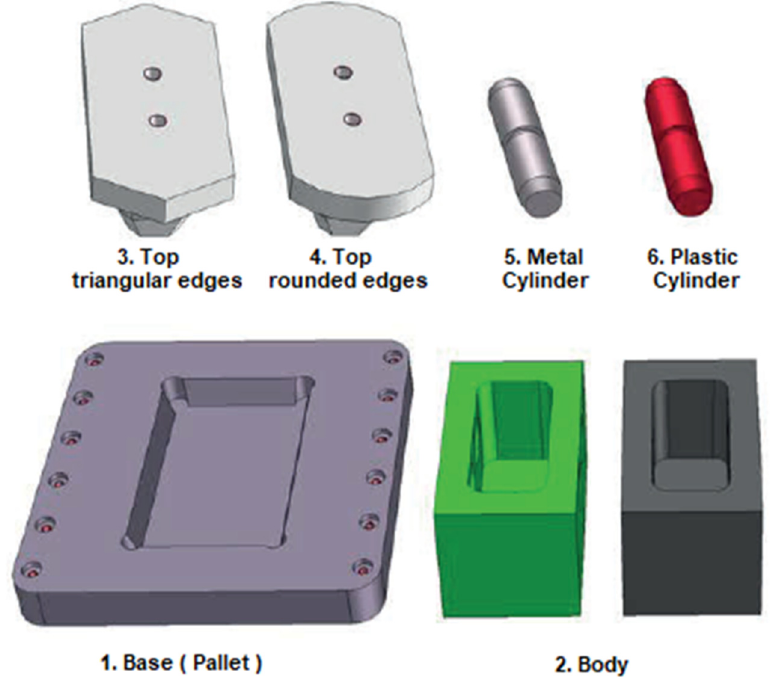
Figure 6. Five-part workpiece components.